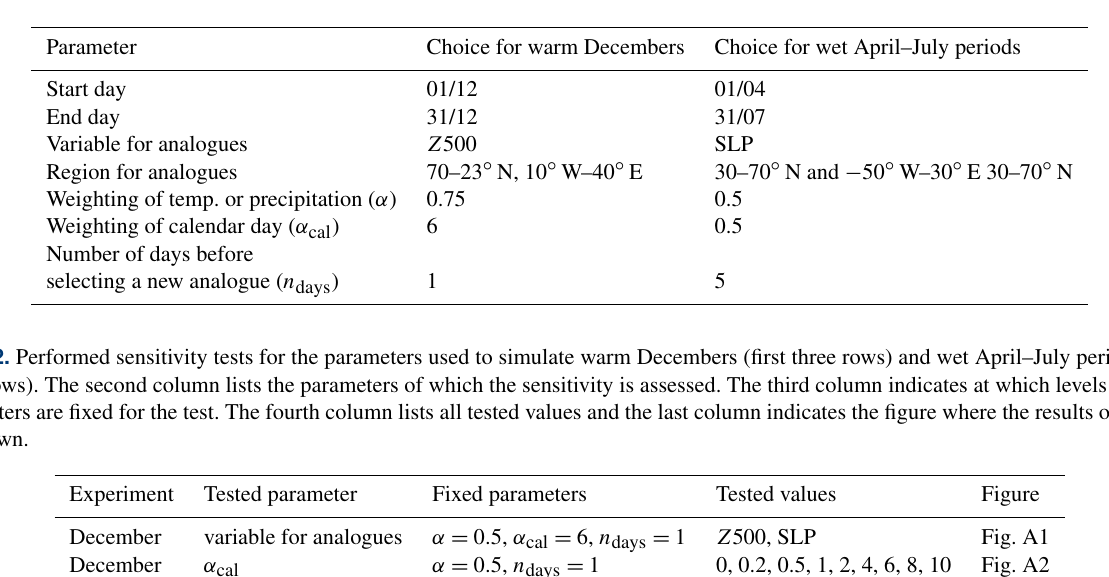
Table 1. Parameters used for the static and dynamic SWG to simulate warm Decembers (second column) and wet April–July periods (last column).